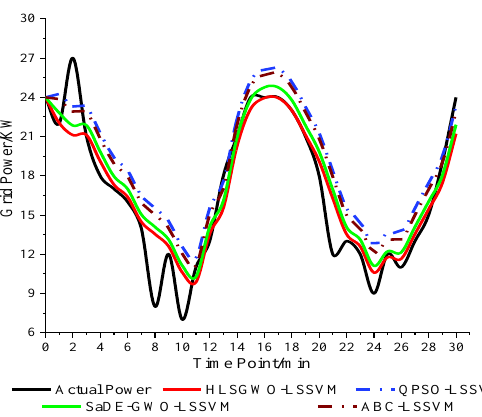
Figure 12. Power smoothing based on the predicted power.